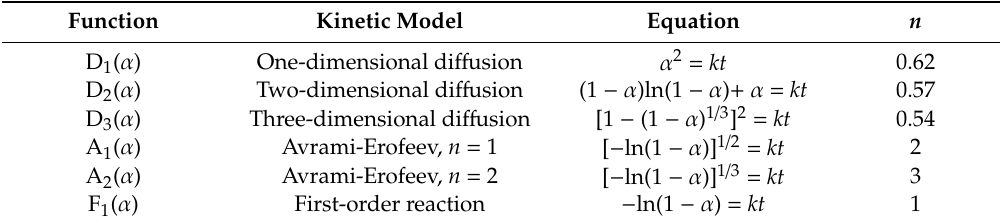
Table 3. The relationship of modal function and judgment index.